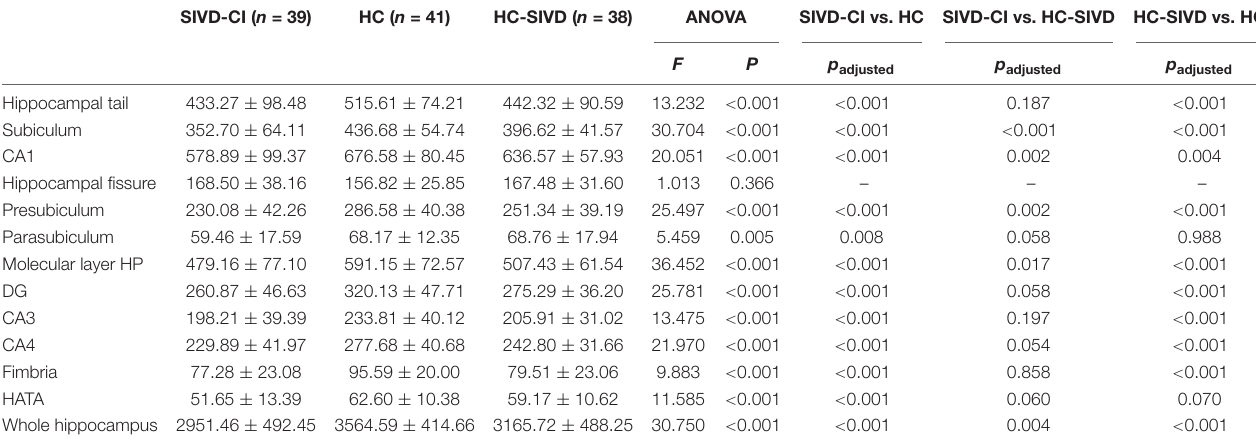
TABLE 3 | Analysis of covariance of the volumes of right hippocampal subfields among the three groups.